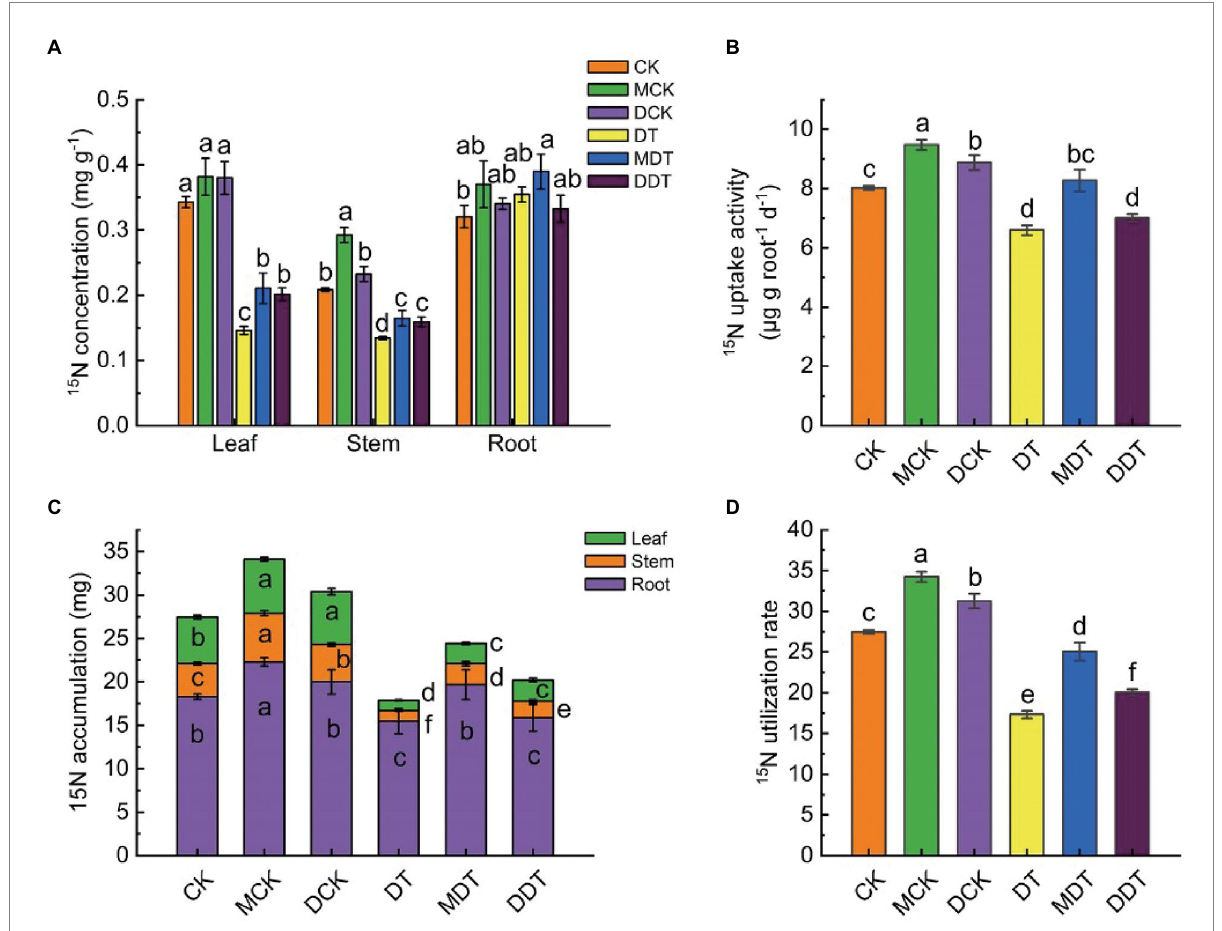
FIGURE 2 The 15 N isotope labeling results. 15 N concentrations (A) and accumulation (C) in different parts of plant, 15 N uptake activity (B) and utilization rate (D) . Data are means ± SD ( n = 5). For each panel, bars not labeled with same letter indicate significant differences at p < 0.05, based on Tukey’s multiple range